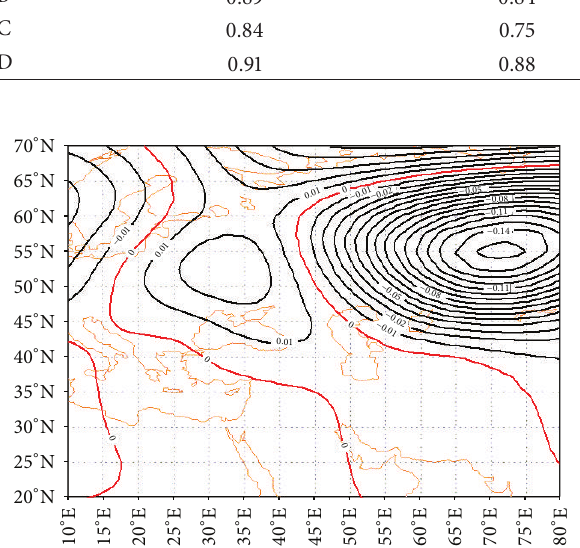
Figure 23: The sixth component of 500 HPa geopotential height level data.